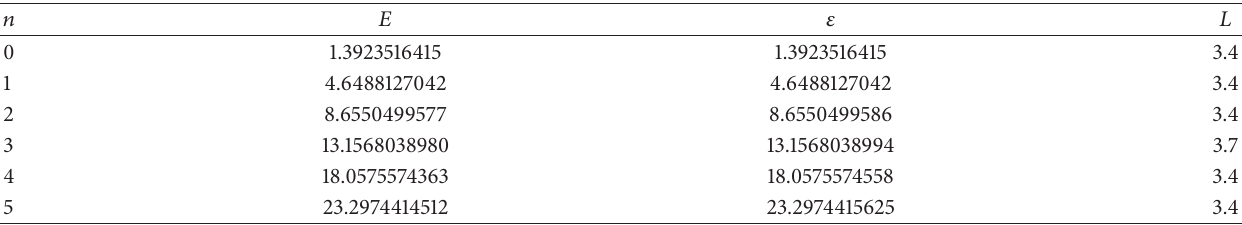
Table 2: The energy levels for the quartic anharmonic oscillator 𝐻 = −Δ+𝑥 2 +𝑥 4 in dimension 𝑅 . 𝑛 represents the energy state, 𝐸 represents the accurate energy values obtained in [1], and 𝜀 is the upper bound to 𝐸 obtained using the present variational analysis in a basis of size H were minimized over the box size, and 𝐿 is the optimal value obtained. The table shows the first 6 states, 𝑁 = 20 . The eigenvalues 𝜀 𝑛 of 𝑛 = 0,1,...,5